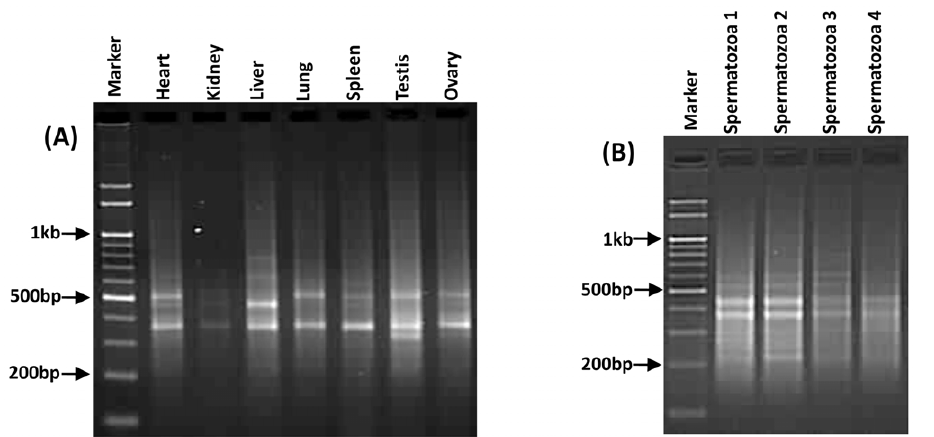
Figure 1. Minisatellite associated sequence amplification conducted using decoy primer (TGG) 5 . Panel ( A )shows bands uncovered by MASA from different somatic tissues and gonads and ( B ) from spermatozoa. The corresponding tissues are indicated above.